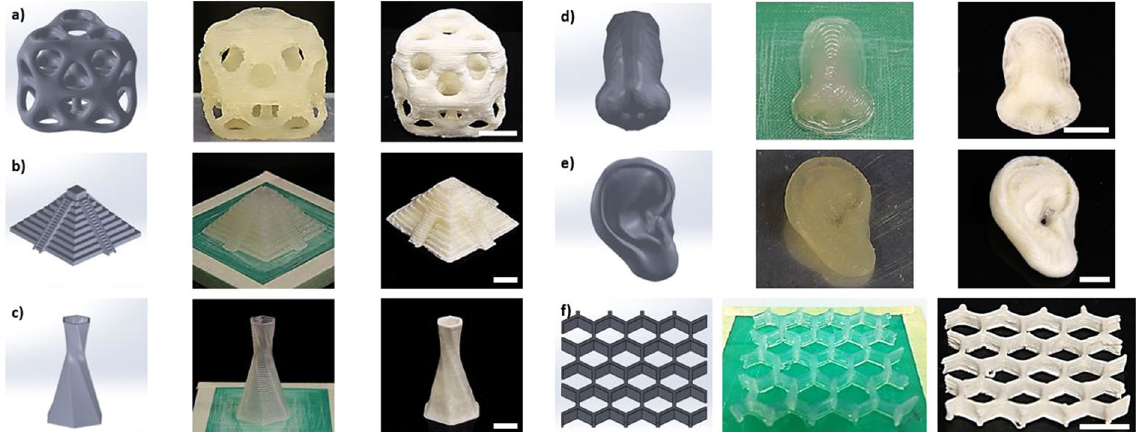
Figure 2. DIW 3D printed ( a ) octet cube, ( b ) pyramid, ( c ) hexagonally twisting vase, ( d ) nose model, ( e ) ear model, and ( f ) honeycomb from 20 wt% CNC gel and 500 µ m nozzle tip. First column is CAD model, second column is DIW 3D printed gel structures, and third column is resultant structures after freeze drying. Displayed scale bars are 1 cm.